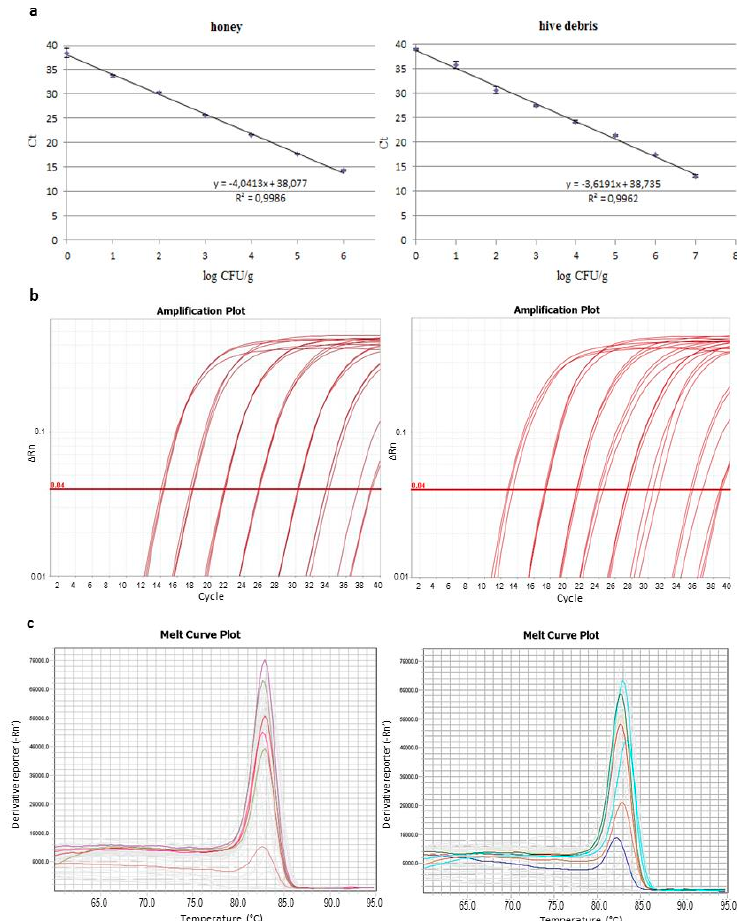
Figure 2. ( a ) Calibration curves used for the quantification of P. larvae spores in honey and hive debris by the qPCR test with primers PLAup/PLAdw: Ct values, defined on the automatic threshold, are the average of those from three replicate reactions; ( b ) corresponding amplification curves; ( c ) melting curves of the amplification products obtained from one series of standards for each sample